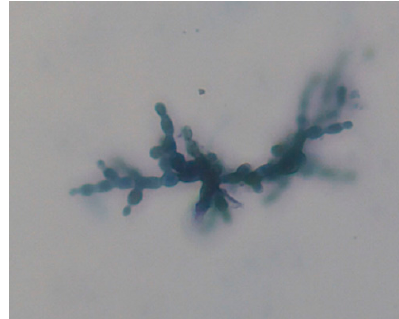
Figure 5. Skin histopathology from a horse with severe dermatitis; mild lymphocytic, hyperplastic dermatitis (H.E. 4× objective). Black arrow indicates hyperplasia (acanthosis) of the epidermis. Red arrows indicate mildly increased surface keratin.